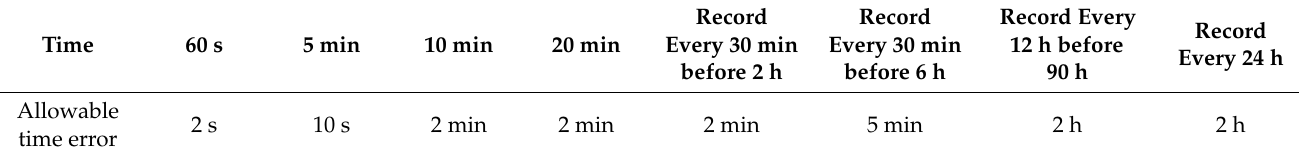
Table 3. Measurement time and allowable time